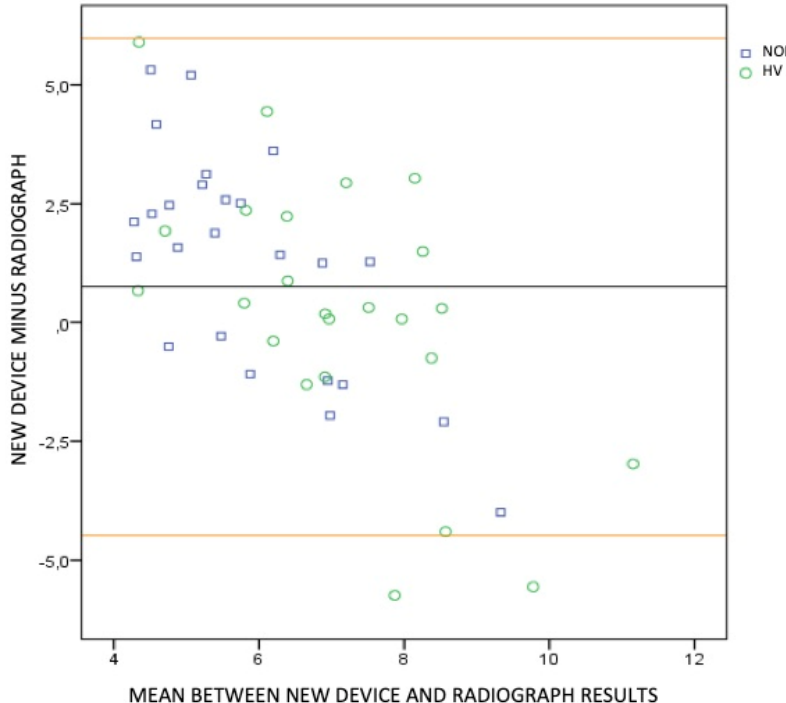
Figure 7. Bland-Altman graph. The dorsiflexion measured with the new device minus the dorsiflexion measured with radiographs was calculated for each participant. The mean and the standard deviation of the obteined results were then calculated (0.75 ± 2.67). This mean and standard deviation were used to calculate the tolerance limits (Lower limit: 0.75 − 1.96 × 2.67 = –4.48. Upper limit: 0.75 + 1.96 × 2.67 = 5.98). These limits are represented by the upper and lower horizontal lines in the graph. The midline represents the mean of the di ff erences obtained between the dorsiflexion measured with the new device and the dorsiflexion measured with radiographs (0.75). Table 6. Area under curve (AUC), sensitivity, specificity, positive predictive value (PPV) and negative predictive value (NPV) of the new device measurements. DF: Dorsiflexion; PF: Plantarflexion; ROM: Range of Motion. DF PF